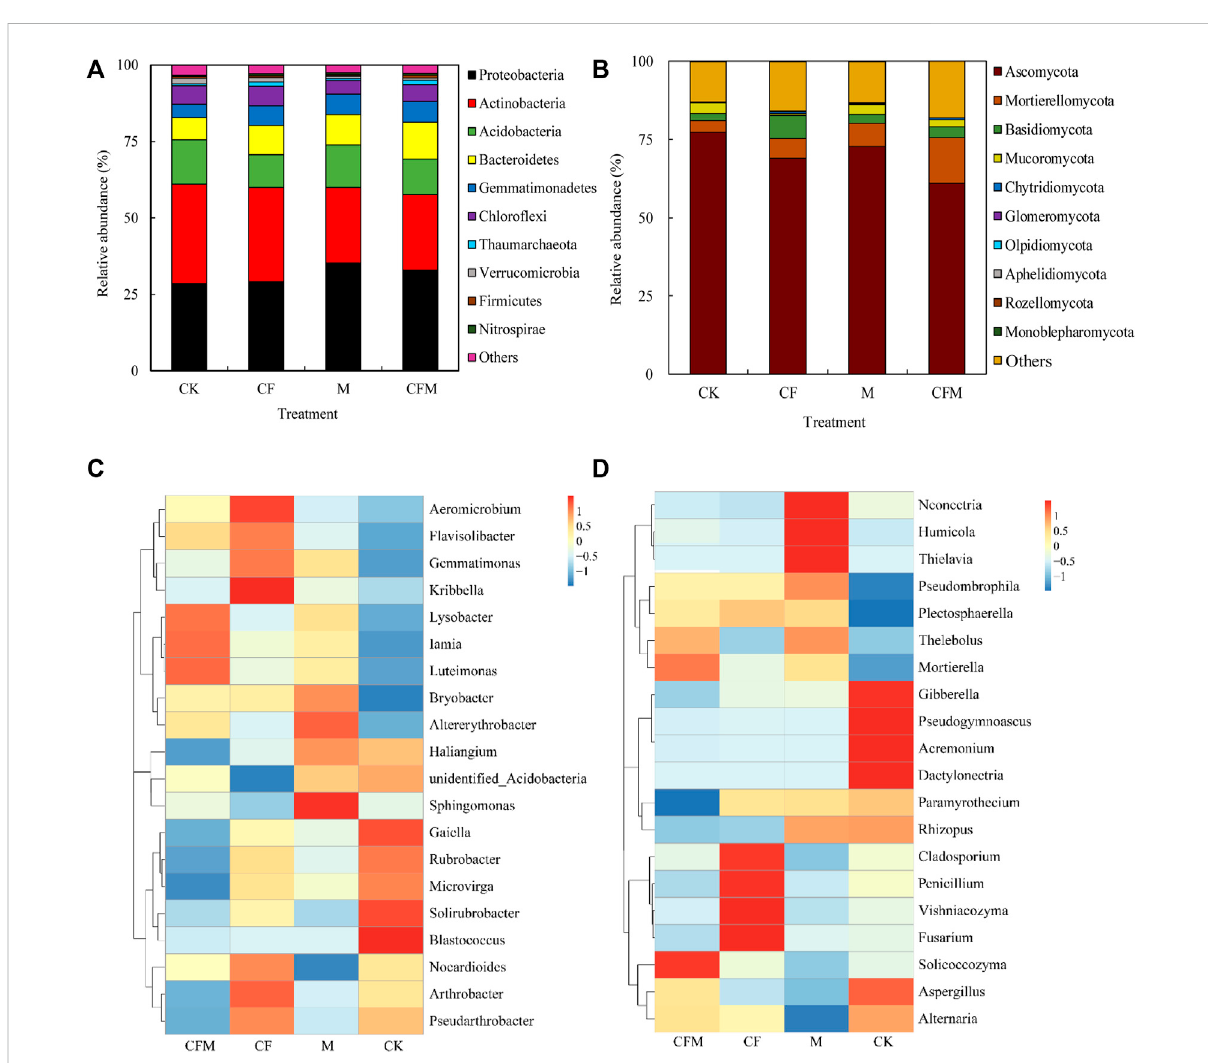
FIGURE 2 Relative abundances of the dominant bacterial and fungal taxa in soils among the different treatments after 16 years (2004 – 2019). Relative abundancesofbacterial (A) ,phylumlevel; (C) ,genuslevel)andfungal (B) ,phylumlevel; (D) ,genuslevel)taxaamongthetreatmentsoils.The10most abundant phyla and the 20 most abundant genera are shown in the panels. The relative abundance of each taxon was calculated using the average relative abundance of that taxa across all of the soils divided by the average total relative abundance of all of the phyla in each